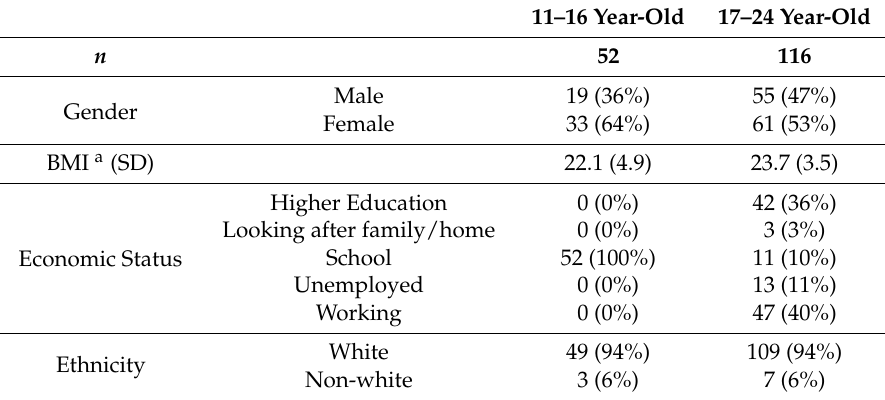
Table 1. Participant demographics (all participants completing at least one corresponding INTAKE24 and interviewer-led recall; n =